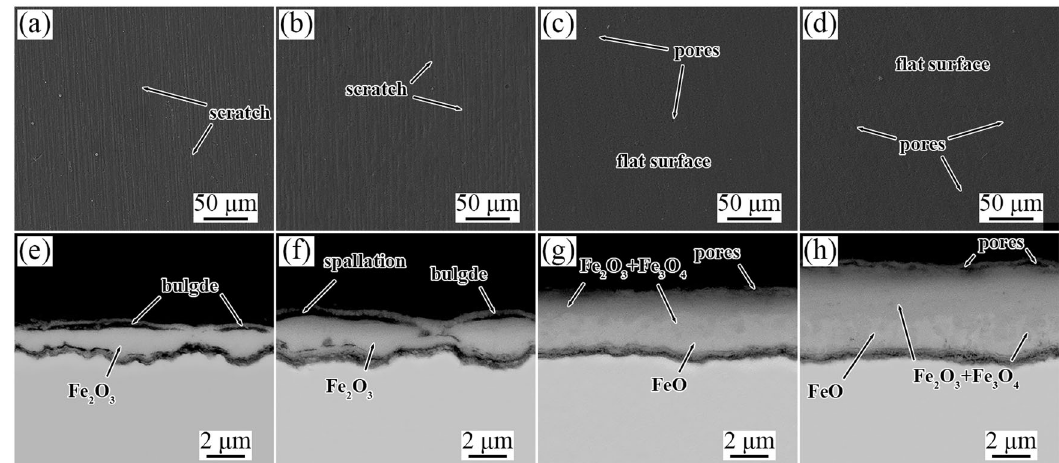
Fig. 5 SEM micrograph of 37Mn5 steels after oxidation at 700 °C. a Surface microstructure for 16 min in air. b Surface microstructure for 30 min in air. c Surface microstructure for 16 min in kerosene. d Surface microstructure for 30 min in kerosene. e Cross-sectional microstructure for 16 min in air. f Cross-sectional microstructure for 30 min in air. g Cross-sectional microstructure for 16 min in kerosene. h Cross-sectional microstructure for 30 min in kerosene.